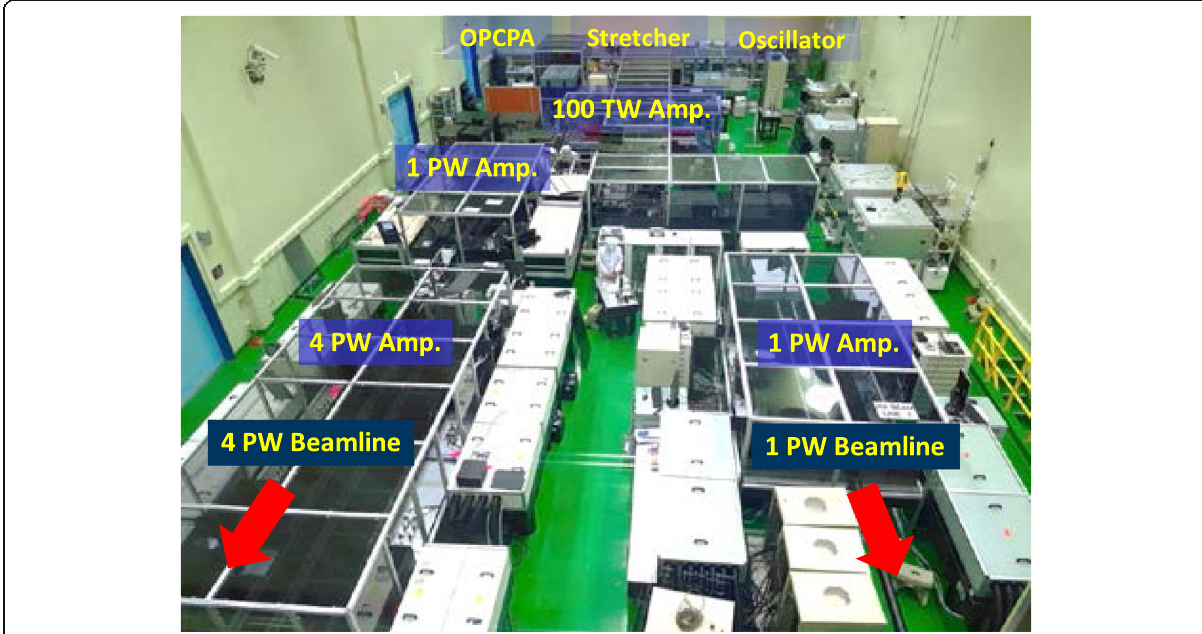
Fig. 4 Multi-petawatt Ti:sapphire laser facility at CoReLS. The 1-PW beamline was constructed in 2010, and the 4-PW beamline in